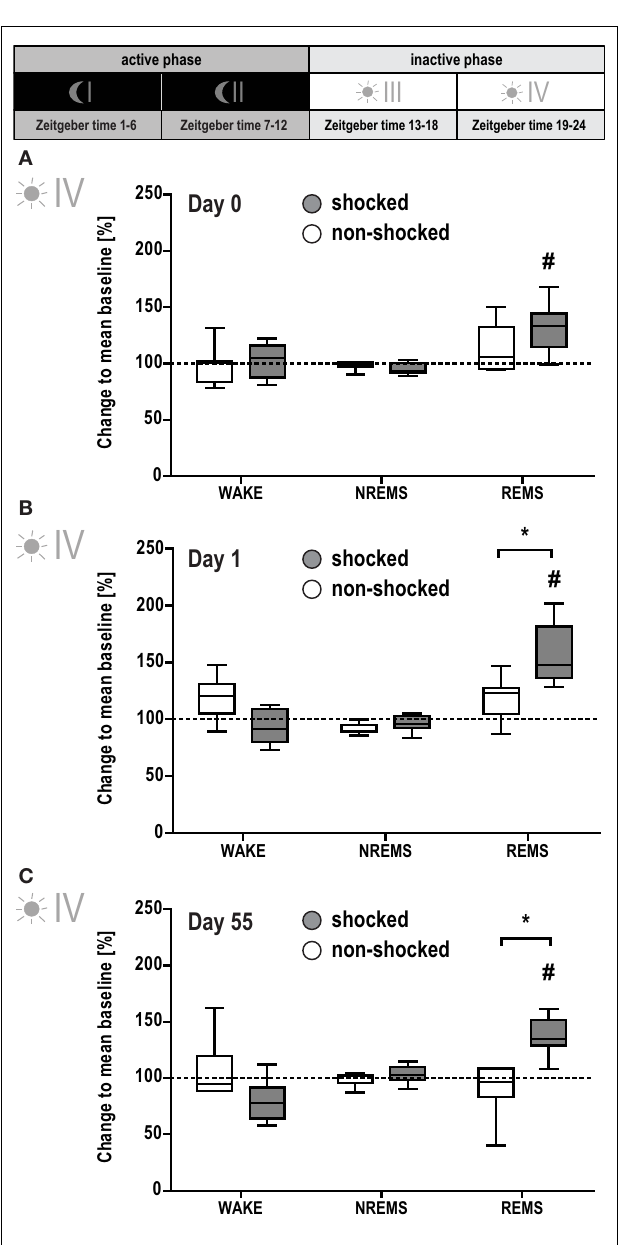
FIGURE 4 | Shocked mice show long-lasting increase in REMS . Sleep-wake behavior of the mice was recorded on the day of the shock [day 0, (A) ], the day after the shock [day 1, (B) ], and 2months after the shock [day 55, (C) ; for experimental schedule, see Figure 1A ]. For each recording day, results of the second half of the inactive (i.e., light) phase are depicted. The individual graphs show the change in time animals spent awake (WAKE), in non-rapid eye movement sleep (NREMS) or rapid eye movement sleep (REMS) relative to the group mean under baseline conditions (dotted horizontal line). Data are presented as box and whisker plots with boxes showing lower quartile, median and upper quartile, and whiskers showing the minimum and maximum sample. * p < 0.0125 indicates a statistically significant difference between shocked (gray) vs. non-shocked control (white) group ( post hoc contrast tests in MANOVA; Bonferroni corrected). # p < 0.008 indicates a statistically significant difference to baseline condition ( post hoc contrast tests in MANOVA; Bonferroni